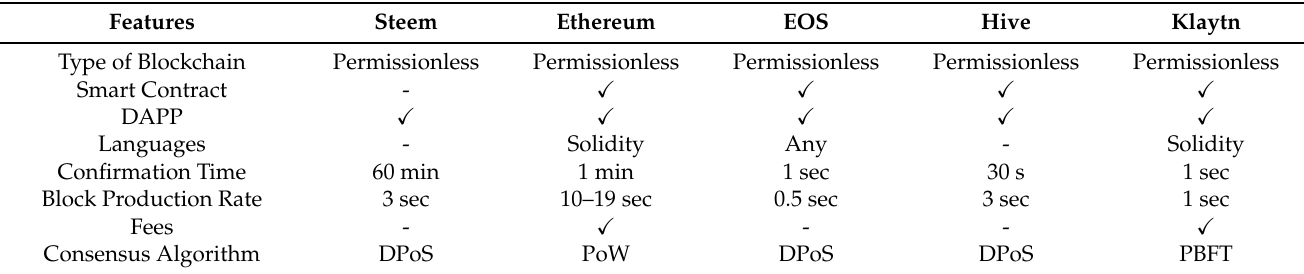
Table 1. Comparative analysis of the popular blockchain